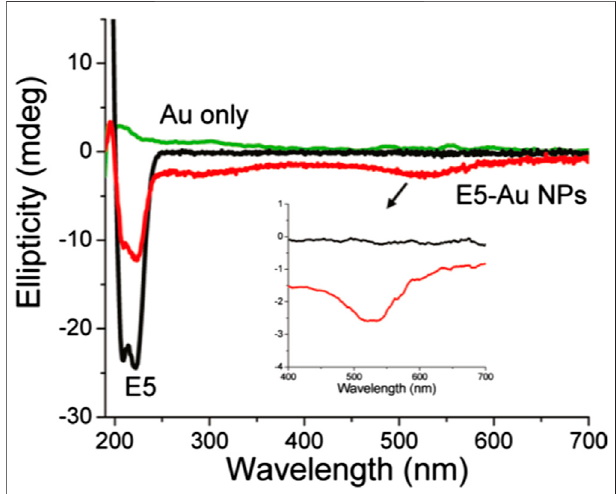
FIGURE 4 | Optical characterization of gold nanoparticles functionalized with the E5 peptide (5.0 μ M) with 1.14 _ 1013 particles/ml. CD spectra of E5 peptide gold nanoparticles with or without E5 peptide. The fi gure and caption have been adapted with permission from Slocik et al., (2011), Copyright © 2011 American Chemical